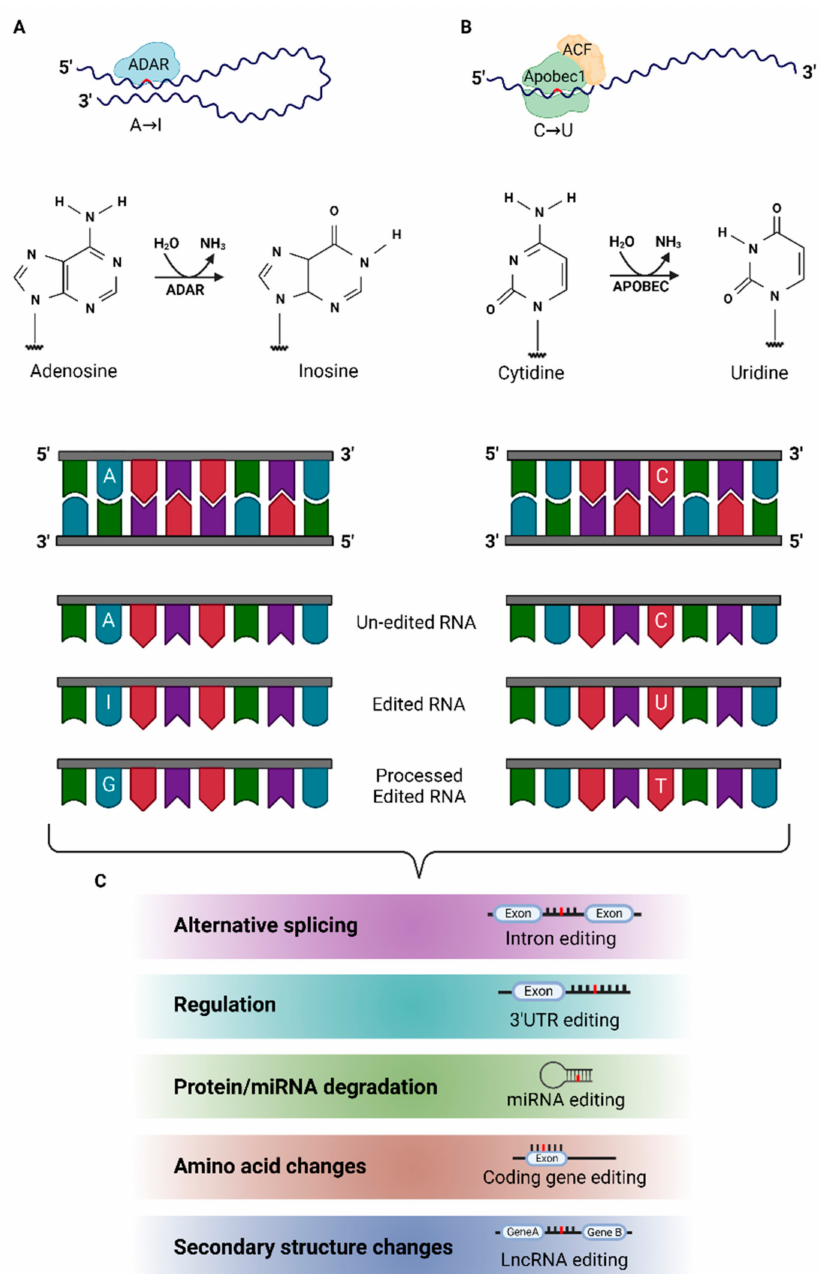
Figure 1. ADAR and APOBEC enzyme members catalyze RNA editing in mammals leading to epi-transcriptomic alterations. ( A ) The mammalian ADAR family comprises three members: ADAR1, ADAR2 and ADAR3. The first two are catalytically active and widely expressed; ADAR3 is expressed exclusively in the brain, has no proven catalytic activity, and is suggested to act as an ADAR1 and ADAR2 regulator. ADARs catalyze A-I editing in the form of homo- and/or heterodimers, without the requirement of other co-factors. Complementary or partially double-stranded RNAs may be used as ADARs’ substrates. Any dsRNA ≥ 20 bp, including protein-coding exons in pre- mRNAs, repetitive sequence elements, as well as microRNA (miRNA) precursor transcripts, may be ADAR substrates. ADARs deaminate Adenosine (A) to Inosine (I). The cellular transcriptional and translational machinery recognizes Inosine (I) as Guanine (G); thus, processed ADAR edited transcripts display a G at the edited site (A-I-G editing). ( B ) APOBEC1 is the main C-U editing enzyme in mammals. APOBEC1-mediated editing is highly specific and requires the formation of